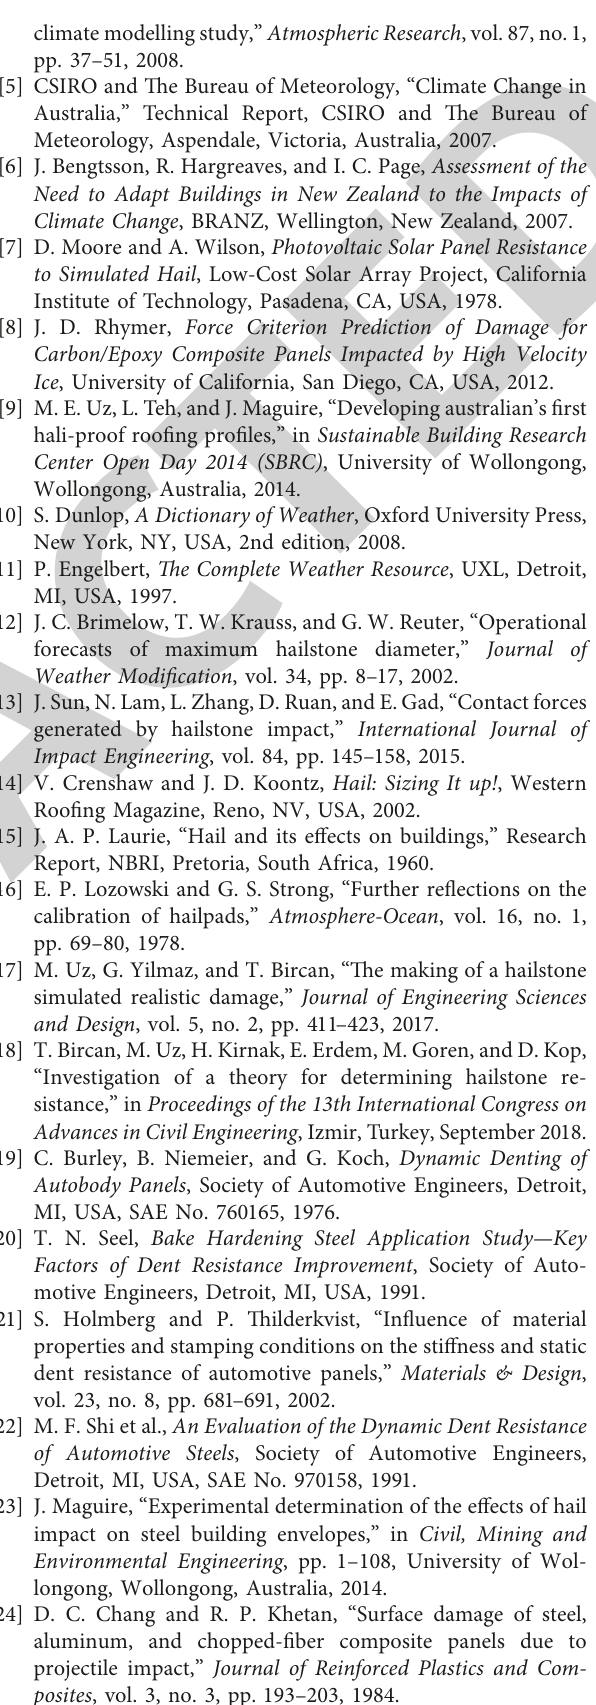
Figure 17: Correlation of D